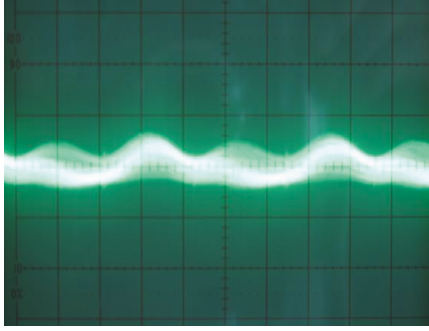
Figure 19: Modulation and demodulation waveform subtraction.